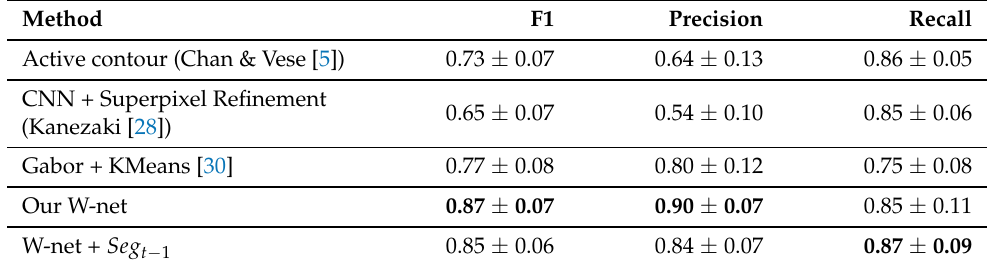
Table 3. Average dice scores on the test set.